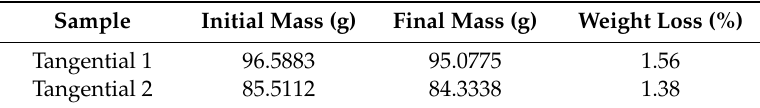
Table 2. Mass loss of impregnated wood samples after 6 h at 35 °C.